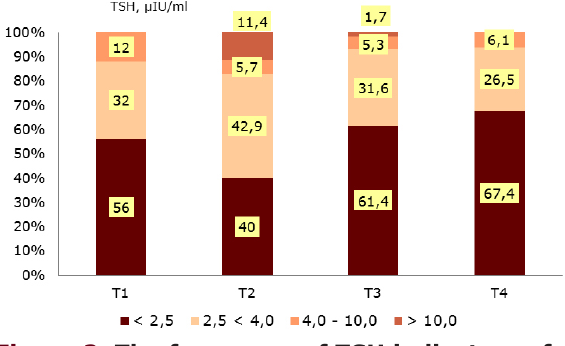
Figure 2. The frequency of TSH indicators of different levels in patients with type 1 dia - betes depending on the stage according to